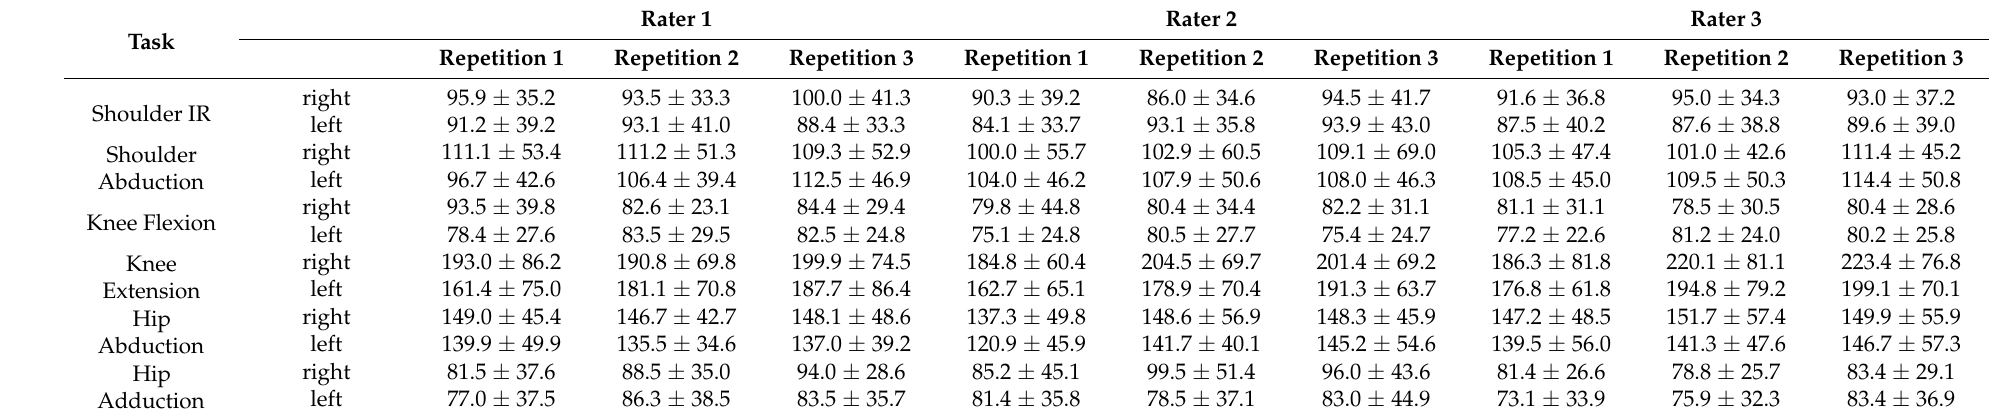
Table 1. Descriptive (mean ± SD) statistics for all the tests and